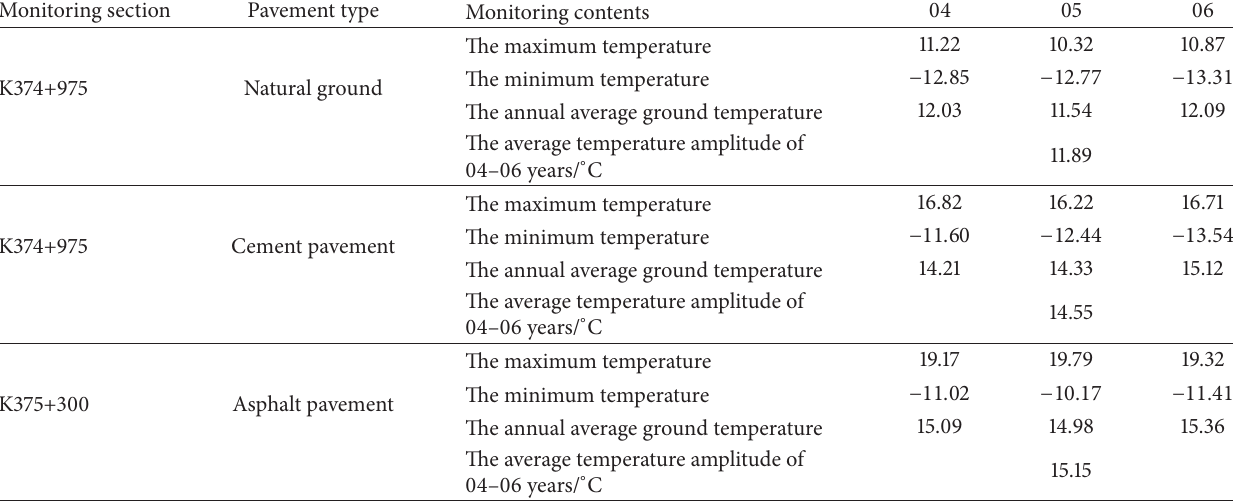
Table 4: The temperature of linear regression in surface of natural ground, asphalt pavement, and cement pavement.